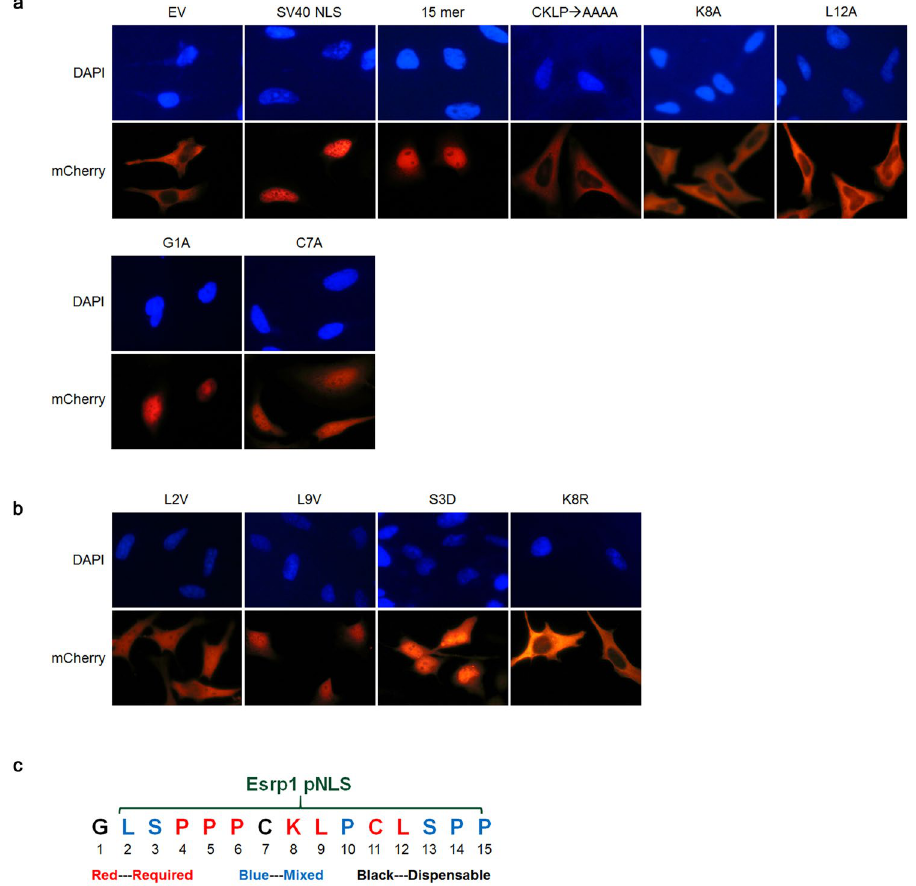
Figure 3. Determination of key residues in the Esrp1 pNLS that are required for nuclear localization. ( a ) Representative images of HeLa cells (20x) transfected with reporter vectors containing the control SV40 NLS and the 15 amino acid Esrp1 sequence as well as representative examples of amino acid substitutions with alanine that abolished (e.g. K8A and L12A) or preserved (e.g. G1A and C7A) nuclear localization. The numbers indicate amino acid positions within the 15 amino acid Esrp1 sequence as shown in ( c ). ( b ) Examples of other amino acid substitutions. ( c ) Summary of key residues in the fifteen amino acid Esrp1 sequence based on alanine substitution. Since the first Glycine is not required for nuclear localization, “LSPPPCKLPCLSPP” is the minimal Esrp1 sequence required for nuclear